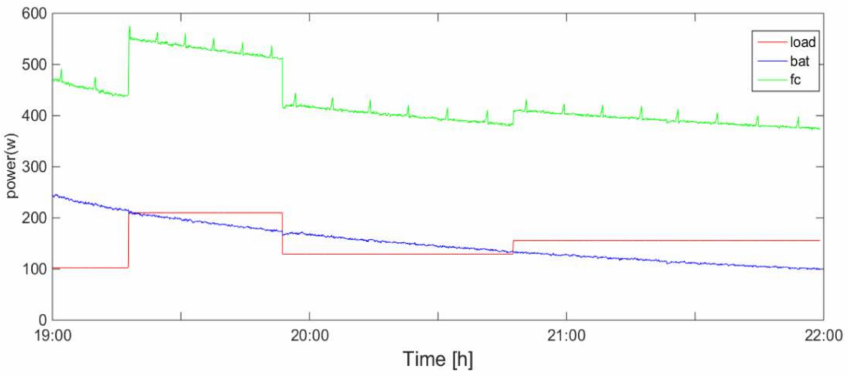
Figure 23. Power curves in scenario 8.